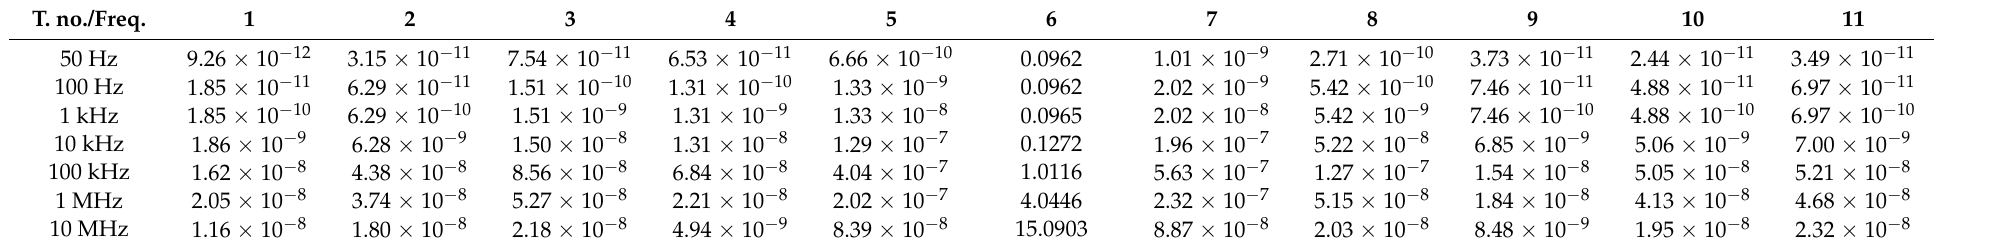
Table A15. Self and mutual resistances of turn 6 (in Ω ) resulting from FEM simulations. T. no./Freq.